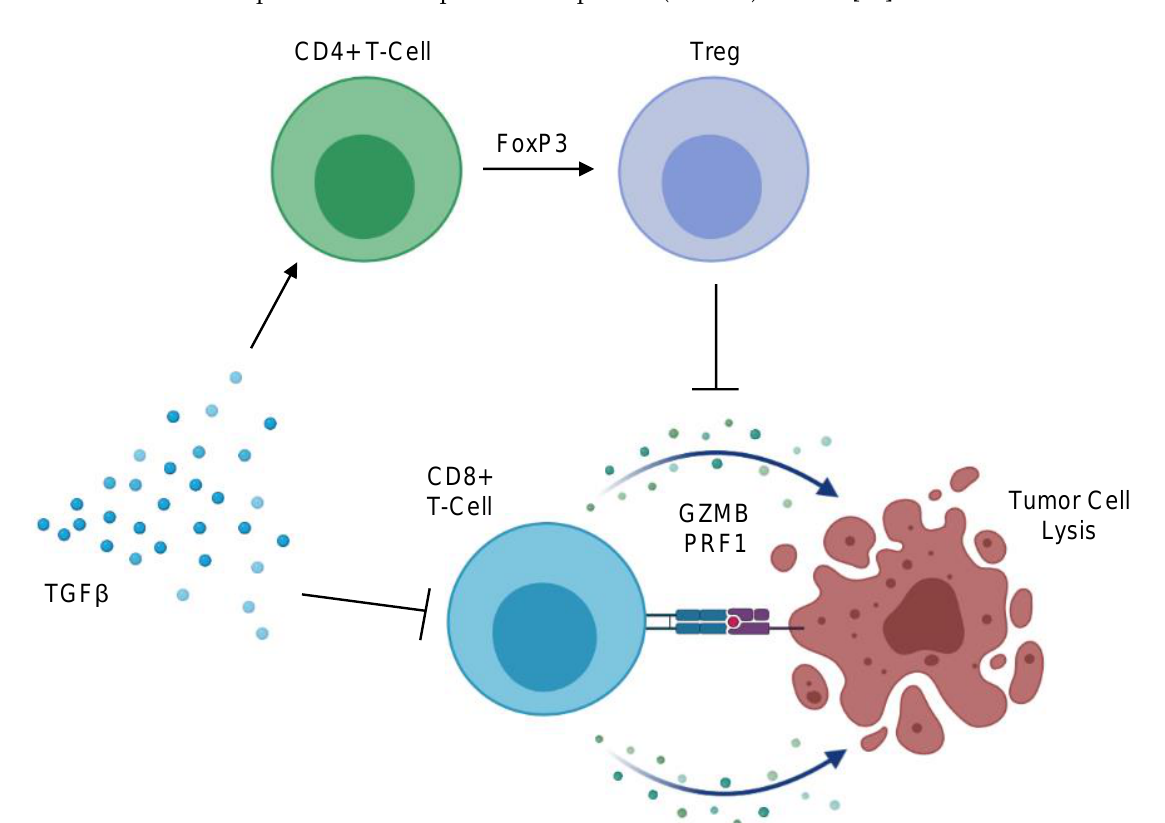
Figure 3. Mechanisms of TGF β -mediated immunosuppression in the PDAC tumor microenvironment. TGF β signaling impedes the anti-tumor immune surveillance program through several mechanisms. TGF β ligands have a pronounced inhibitory effect on the genesis and effector function of CD8 + cytotoxic T-cells, leading to the transcriptional repression of functional cytokines including Granzyme B (GZMB), Perforin 1 (PRF1), and interferon- γ. As a result, these CD8 + T-cells remain refractory from full activation and fail to mount a full anti-tumor immune response. Additionally, TGF β signaling acts on CD4 + helper T-cells, acting to upregulate Forkhead box protein P3 (FoxP3). This leads to the peripheral conversion of CD4 + helper T-cells to immunosuppressive regulatory T-cells (Tregs). Tregs suppress sterilizing immunity via the secretion of suppressive cytokines such as TGF β and IL-10, as well through the surface expression of immune checkpoint molecules.